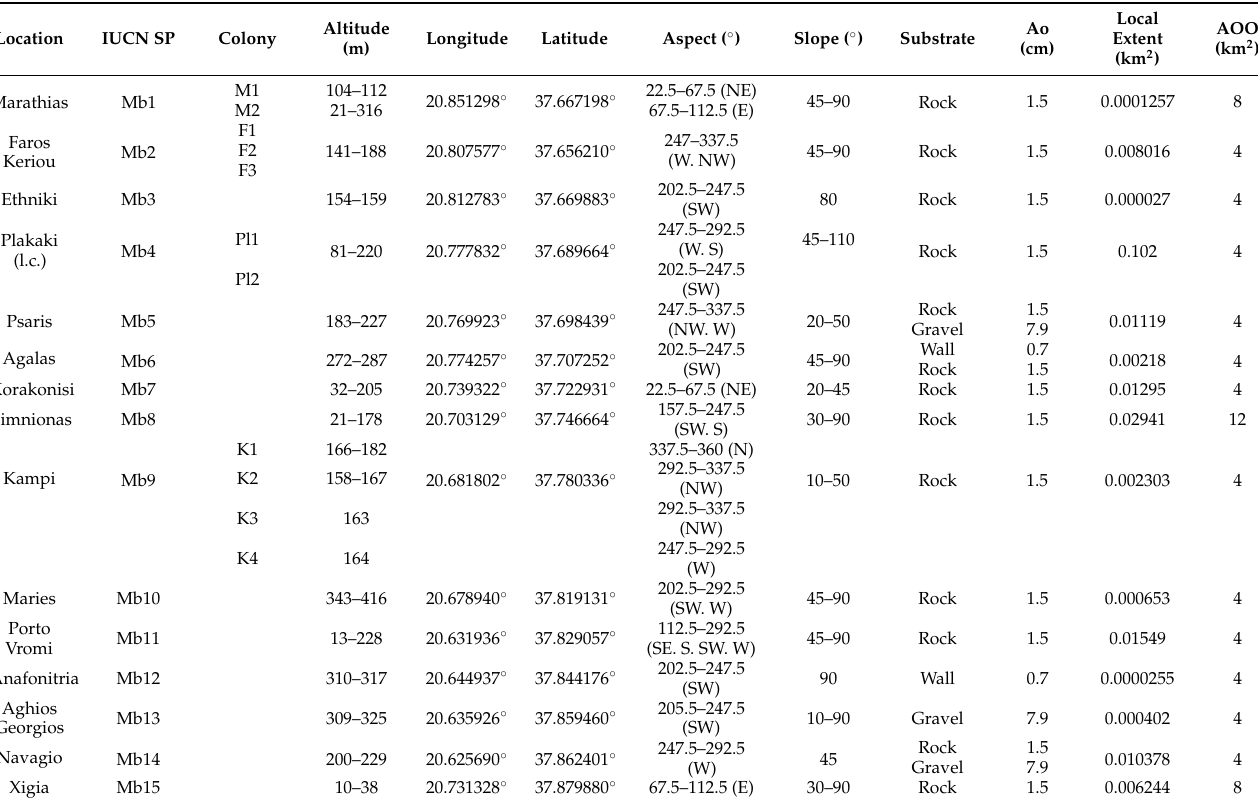
Table 1. Geographical data of Micromeria browiczii subpopulations. Abbreviations as follows: SP, subpopulation; Ao, depth of organic horizon; local extent, the minimum area polygon or polygons including all the plant colonies not separated by unsuitable habitat at each location; AOO, area of